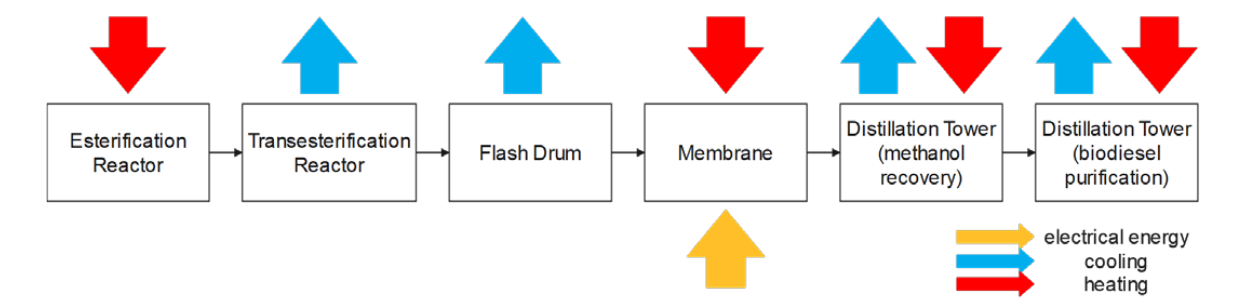
Figure 5. Effect of RSO to methanol ratio on the flow rate of each reactor product.